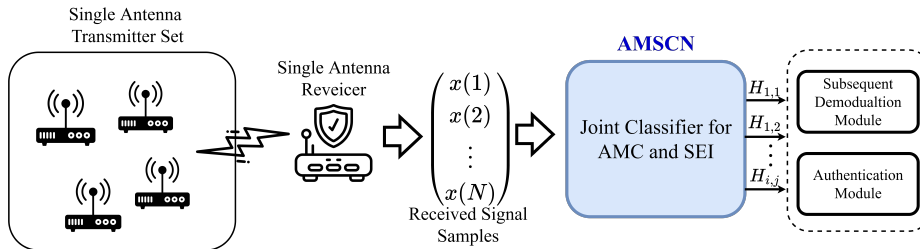
Figure 1. The modulation and transmitter joint-identification framework.